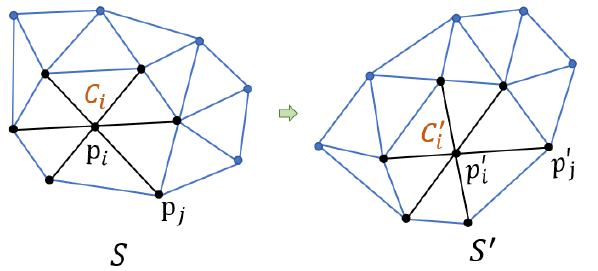
Figure 1. The illustration of local rigid deformation. Cell C i and its deformed version C (cid:48) of these black